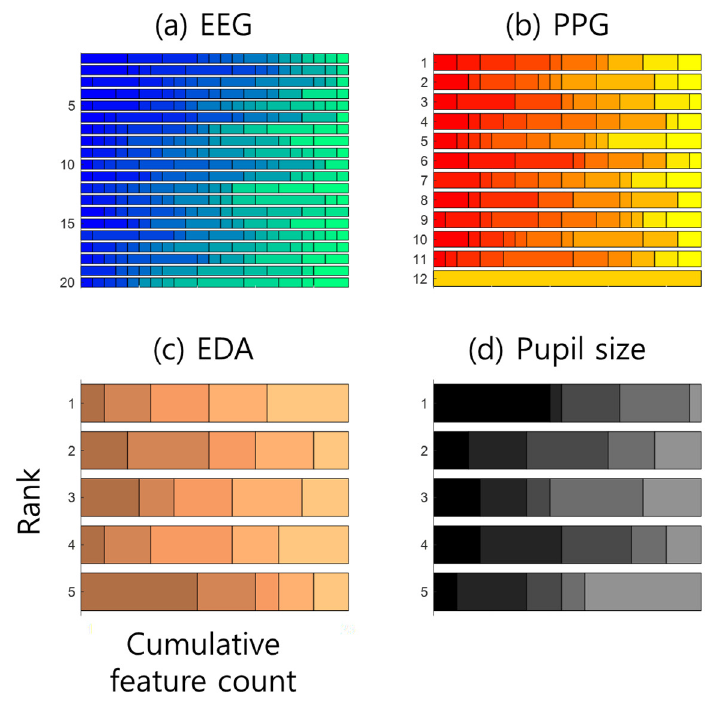
Figure A1 . The cumulative feature count results from each of four biosignals.